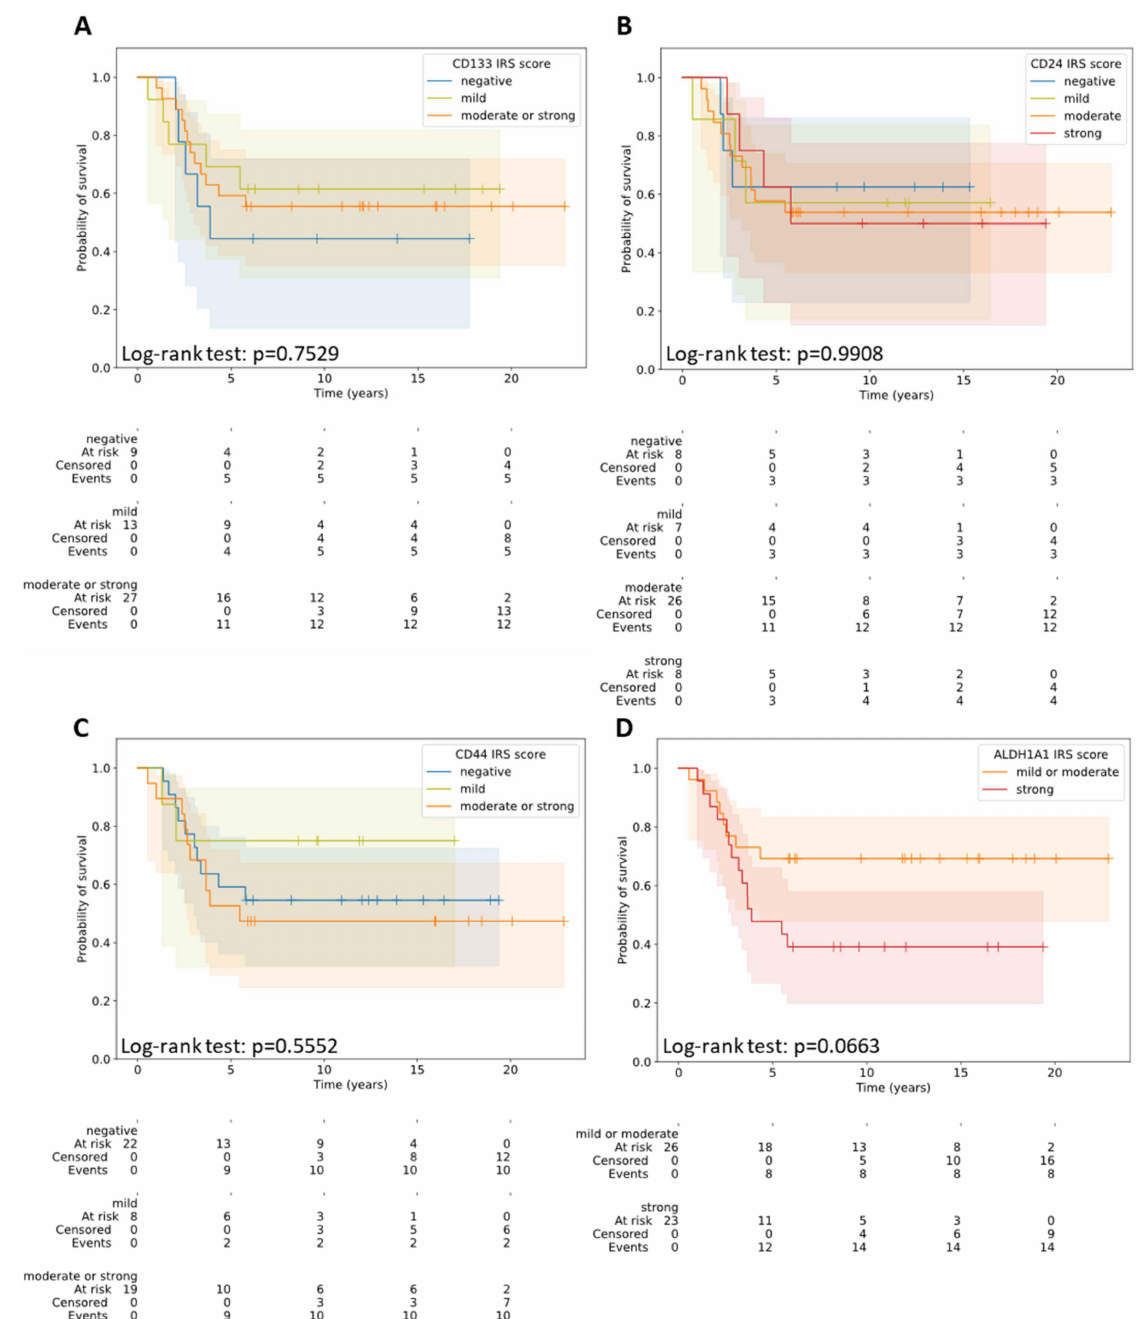
Figure 2. Overall survival in the patients with different IRS scores for CD133 ( A ), CD24 ( B ), CD44 ( C ), and ALDH1A1 ( D